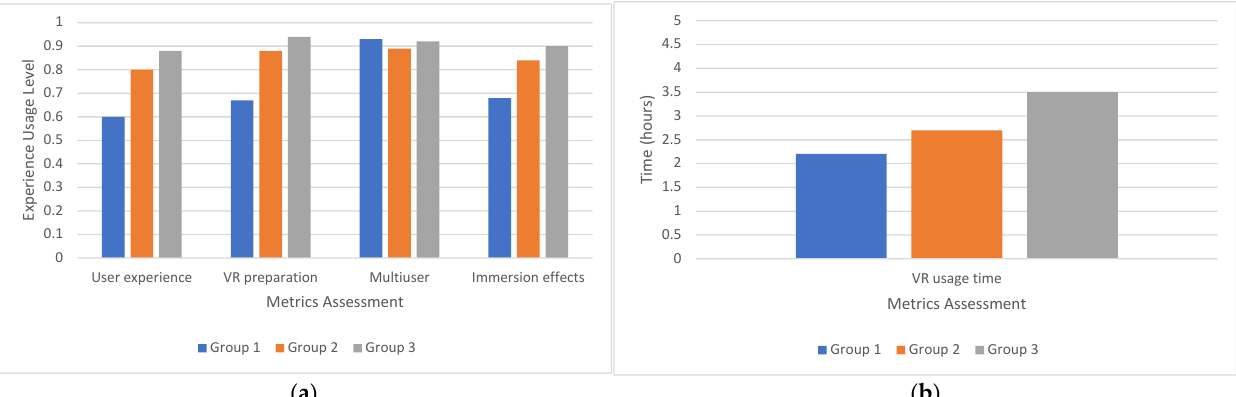
Figure 8. Usability testing: ( a ) four applicable parameters of the metrics; and ( b ) VR usage time.